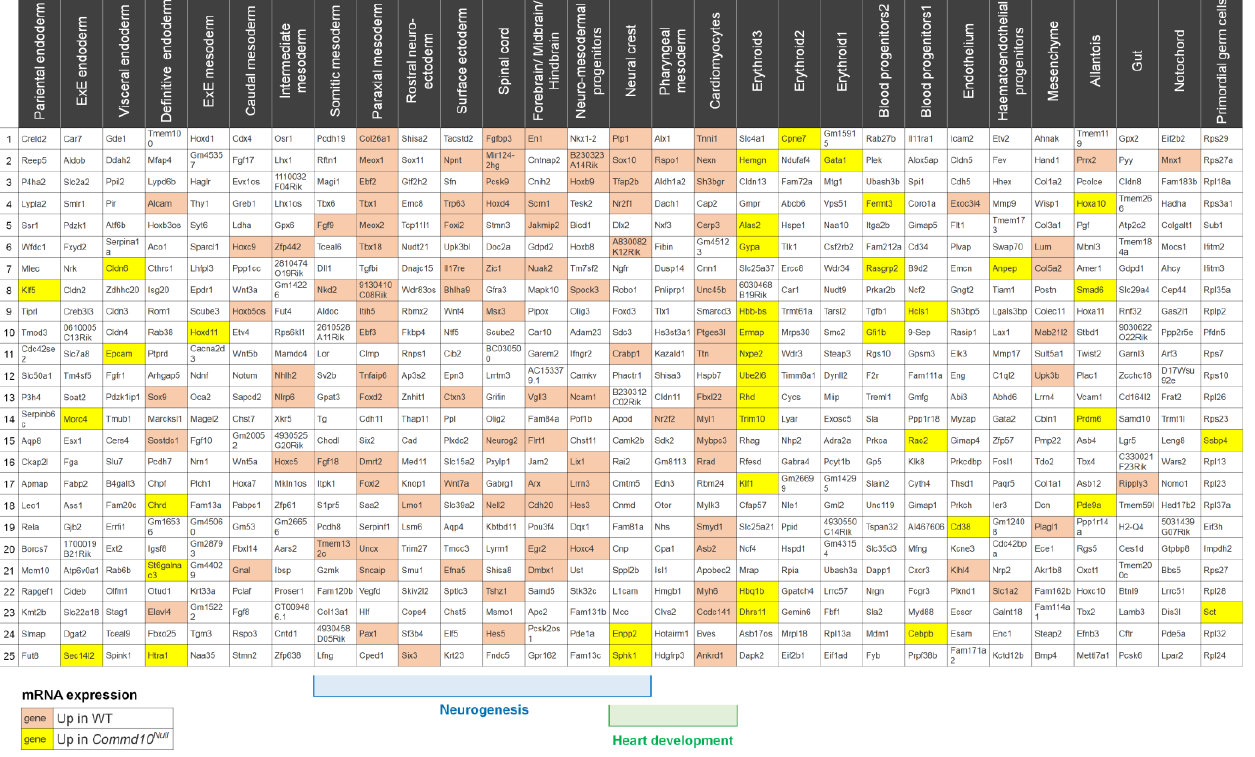
Figure 5. Tissue distribution of differentially expressed genes in Commd10 Null embryos on E8.5. The top row of table lists 29 cell lineages/tissues present in normal mouse embryos at the E8.5 stage of embryogenesis. The columns list the top 25 lineage-specific gene markers for each tissue. All lists were found on a single-cell molecular map of mouse gastrulation and early organogenesis. at https://marionilab.cruk.cam.ac.uk/MouseGastrulation2018/ (accessed on 22 October 2022) website. Genes that are significantly expressed at lower levels in Commd10 Null embryos when compared with WT are shaded in red. Genes with higher expression in Commd10 Null are shaded in yellow. Blue and green brackets below the table mark cell lineages/tissues involved in neurogenesis and heart development, respectively.